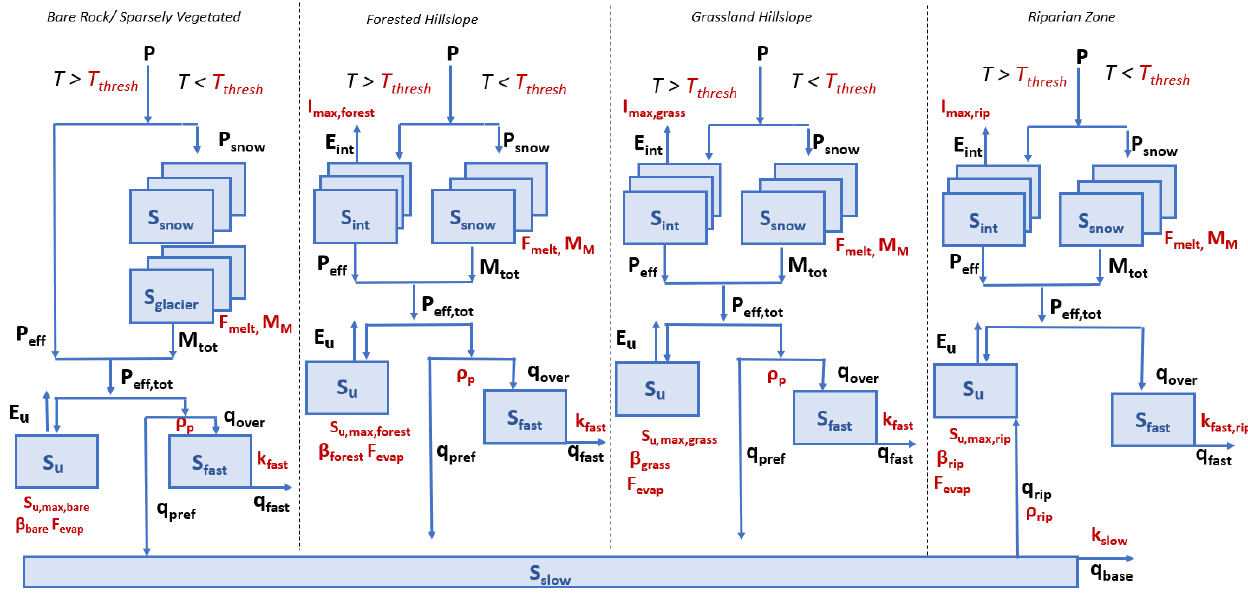
Figure 2. Schematic representation of model structure per precipitation zone, showing model states (blue), fluxes (black) and parameters (red). Table 4. Signatures and the associated objective functions (Obj n ) used for model calibration and post-calibration model evaluation, including the Nash–Sutcliffe efficiency ( E NSE ), the volumetric error ( E VE ) and the relative and absolute error ( E RE , E AE